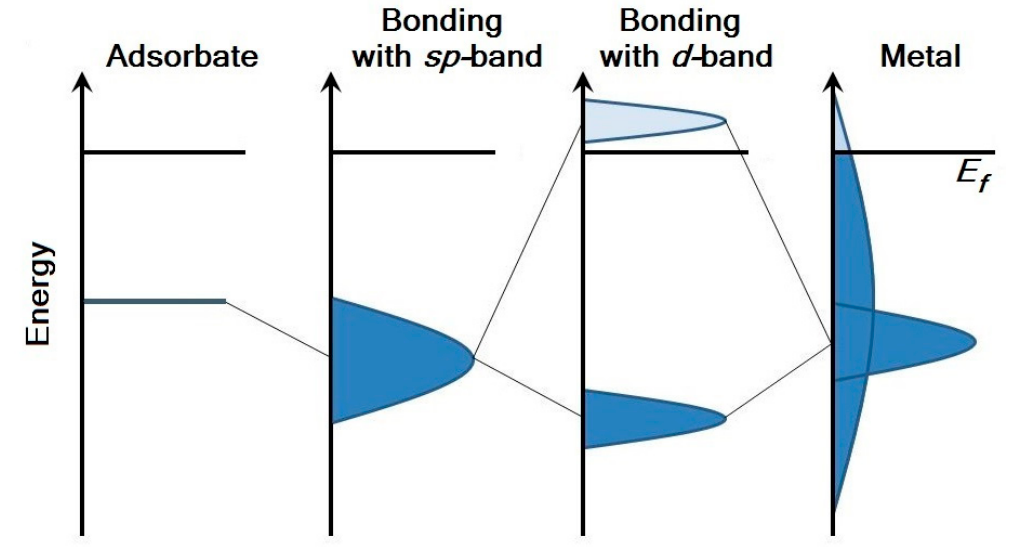
Figure 3. Schematic representation of the change in the local electronic structure of an atom in the case of adsorption on the surfaces of simple (alkali) and transition/noble metals.